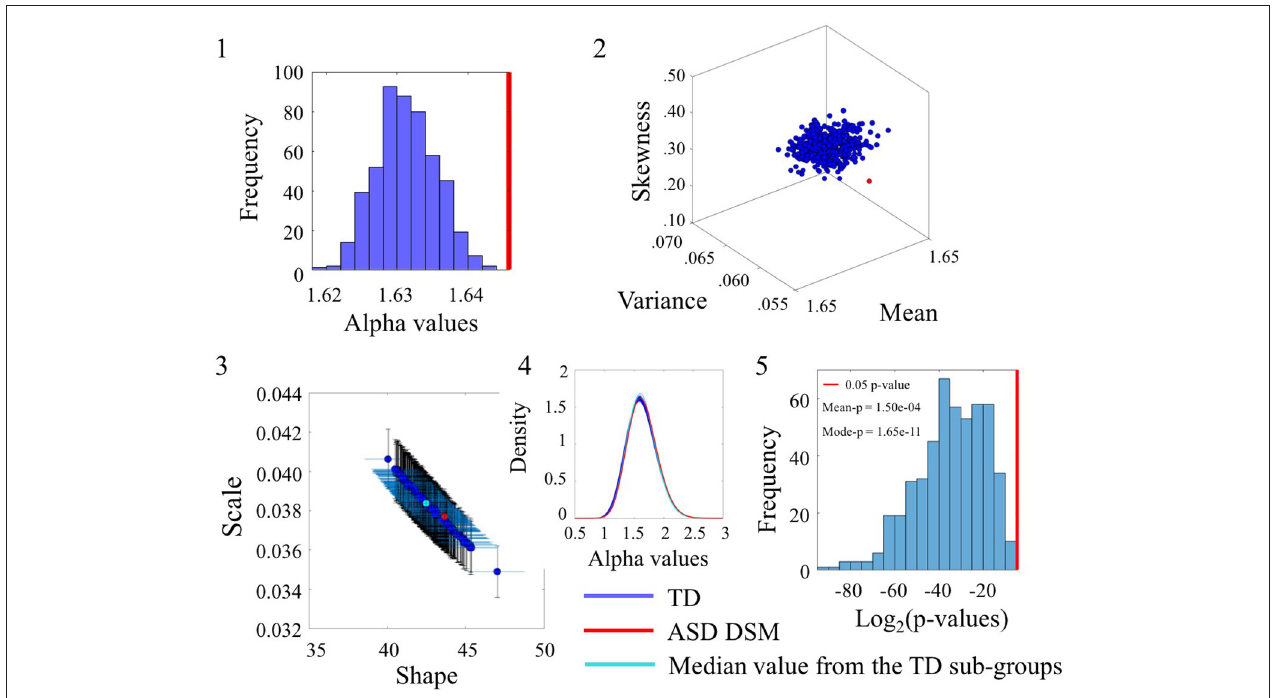
FIGURE 4 | Comparison of the α values between TD and ASD DSM groups for the Angular Speed (SR0 groups). (1) Distribution of the mean of the alpha values for the 500 sub-groups extracted from original TD group with similar size and age composition as the ASD DSM group. The red vertical line represents the mean of the alpha values of the ASD DSM group. (2) Estimated Gamma moments (red dot for the small group, blue cluster of 500 dots from the bootstrapping with 456 age-matched participants in each sub-group and the cyan dot for the median of those sub-groups). (3) Estimated shape and scale Gamma values with confidence intervals on the Gamma parameter plane. (4) Estimated PDFs. (5) Distribution of p -values (log2 scale for better visualization) with the red line as the reference 0.05 significance-level value. The mean and mode of the p -value distribution is also